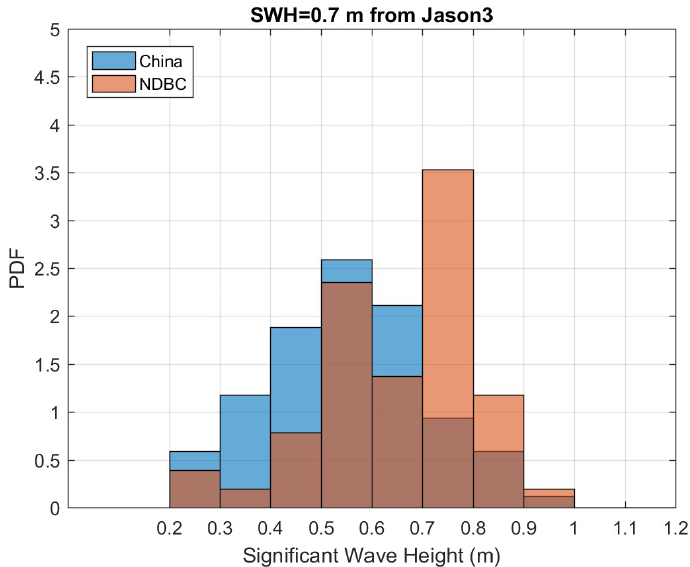
Figure 4. The SWH distribution of Chinese buoys and NDBC buoys when Jason-3 SWH is 0.7 m.